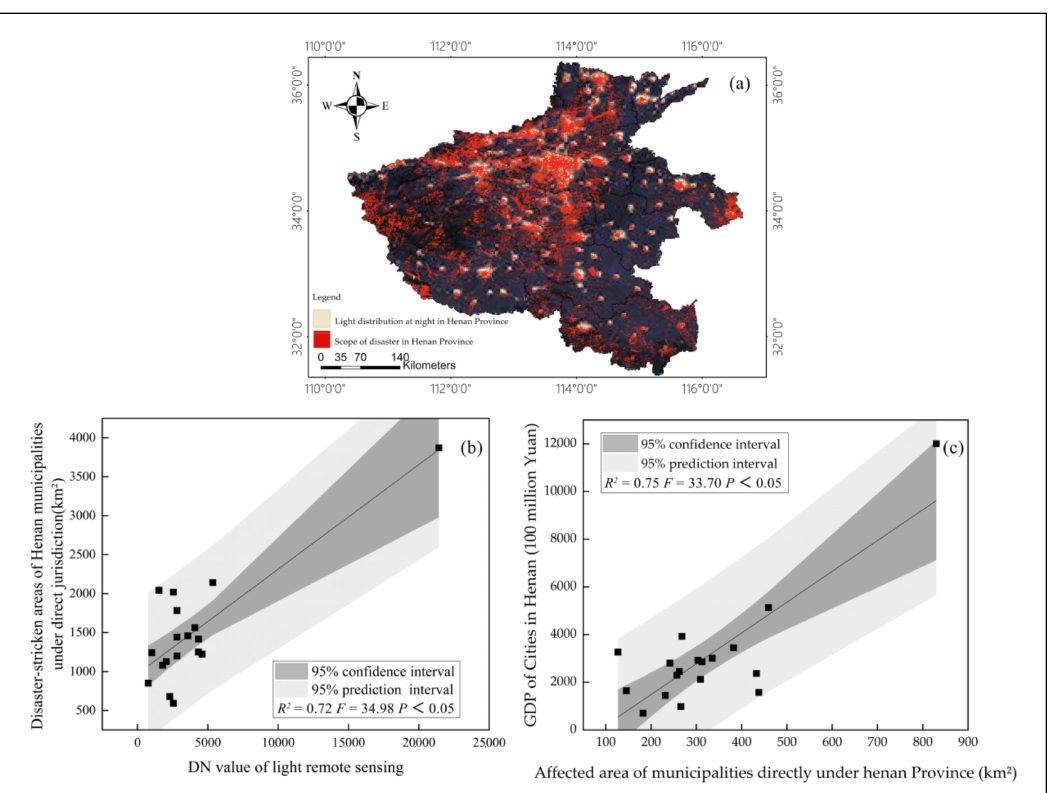
Figure 7. Regional comparison and regression model map of lighting DN value, GDP, and flood dis- tribution in Henan Province: ( a ) Comparison map of regional lamp DN value and flood distribution area in Henan Province; ( b ) Establishment of regression model for corresponding remote sensing lighting pixels and urban disaster-stricken area in Henan Province; ( c ) Remote sensing lamp pixel (DMSP/OL, DN value) and regression model of urban disaster area and urban